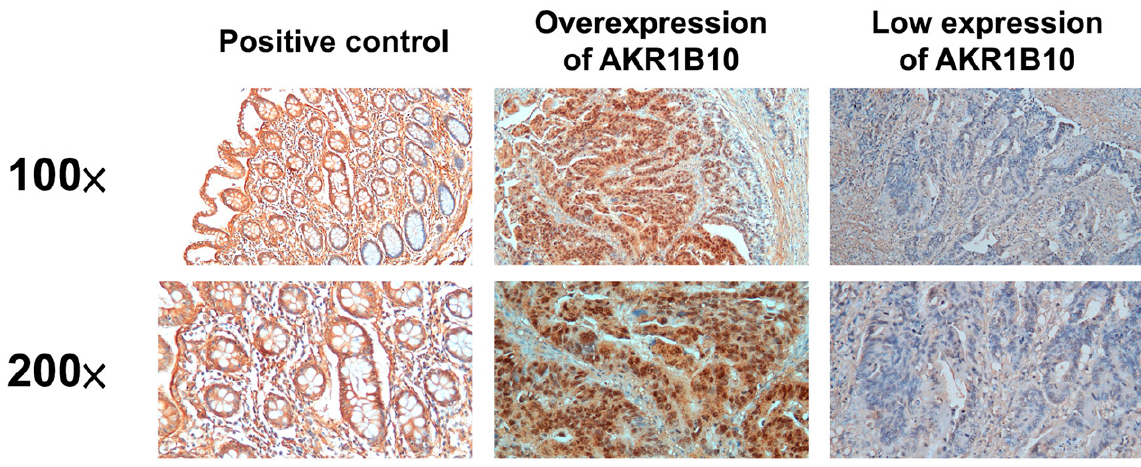
Figure 1. The immunohistochemical analysis of AKR1B10 in gastric cancer patients who received gastrectomy with D2 lymph node dissection.